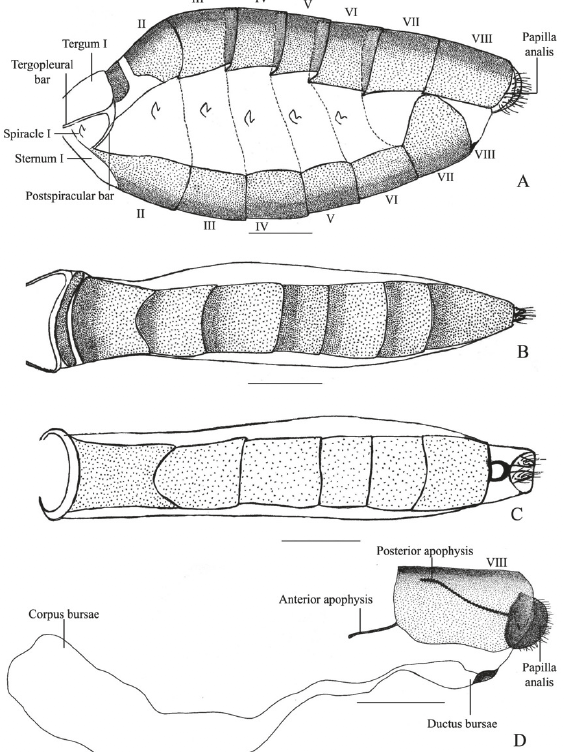
Figure 18. Female genitalia of Junonia atlites (Linnaeus, 1763) A – C - abdomen (lateral, dorsal and ventral view); D - female genitalia (lateral view). Scale bar